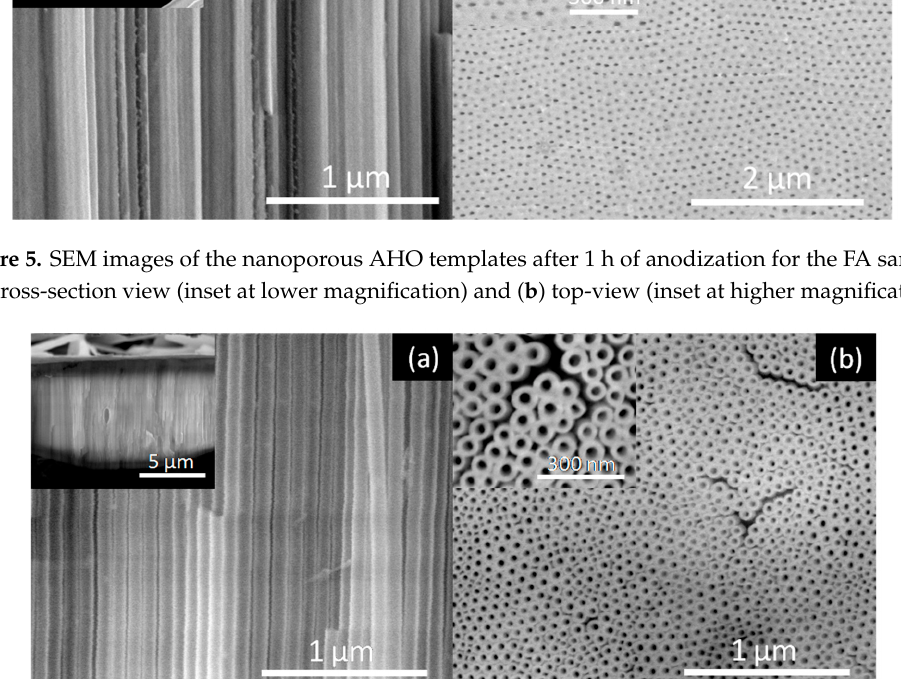
Figure 6. SEM images of the AHO NTs after 1 h of anodization for the EG sample: ( a ) Cross-section view (inset at lower magnification) and ( b ) top-view (inset at higher